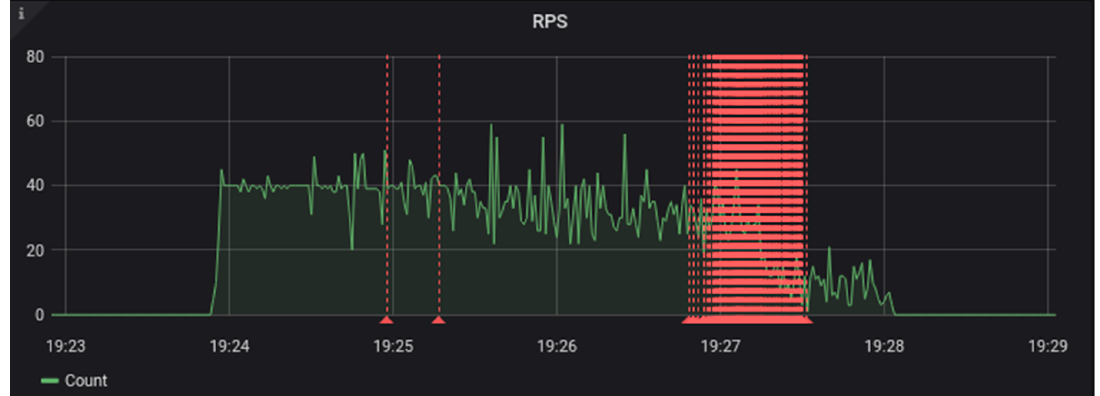
Figure 4. Fedora PostgreSQL system shows error responses at 40 requests per second.